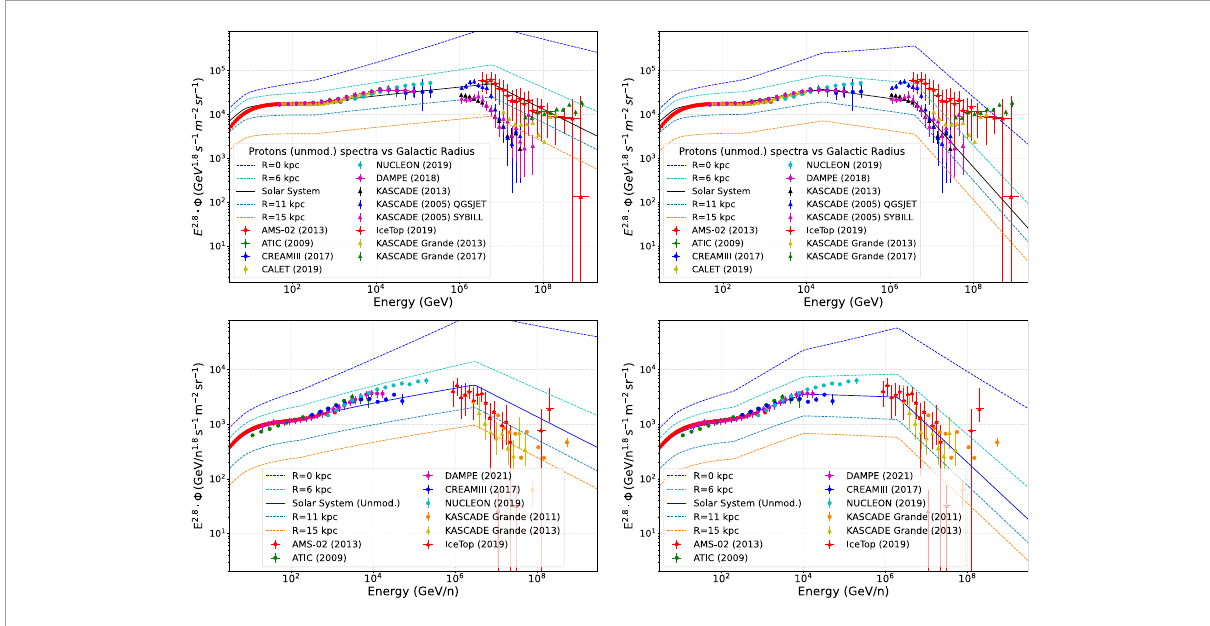
FIGURE 1 Spectra of protons (upper panels) and helium (lower panels) of the γ - optimized scenario for the Max (left panels) and Min (right panels) configurations, from 10 GeV to 10 9 GeV. Since in the γ - optimized scenario the propagation of CRs depends on the distance from the galactic center, we show the spectra at different galactocentric radii. Available local CR data from AMS-02, ATIC, CREAM, CALET, NUCLEON, DAMPE, KASCADE, KASCADE Grande and IceTop are included for